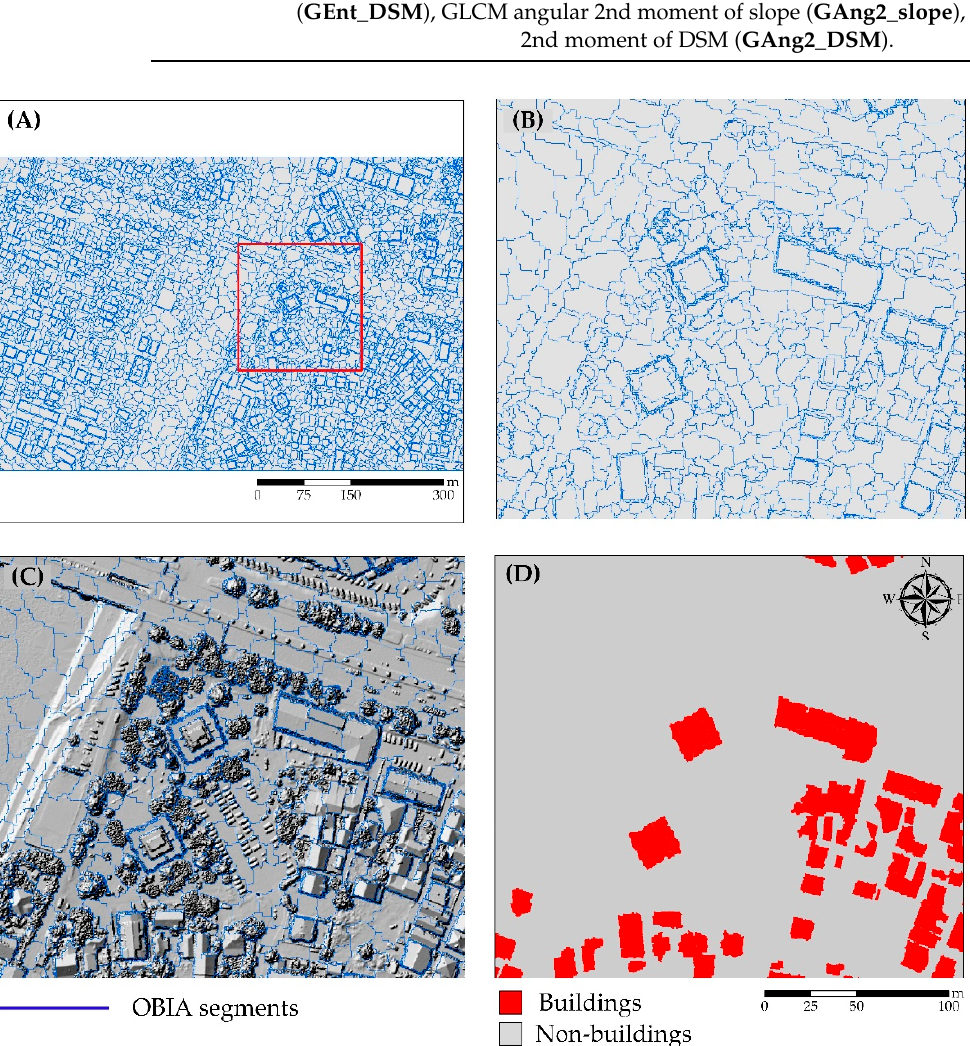
Figure 5. OBIA segmentation and training; ( A ) segmentation over whole study area; ( B ) segmentation detail; ( C ) segmentation detail over hillshade; and ( D ) training data, detail.